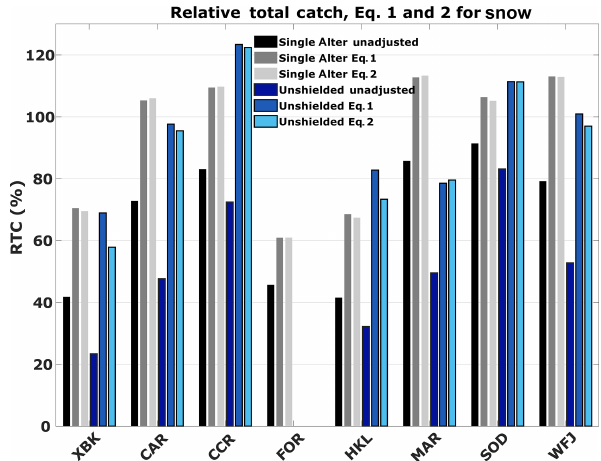
Figure 5. Relative total catch (RTC) of snow (as compared to the DFAR) for single Alter and unshielded gauges for both Eqs. (1) and (2) at each of the eight SPICE sites, combining the 2015/2016 and 2016/2017 winter